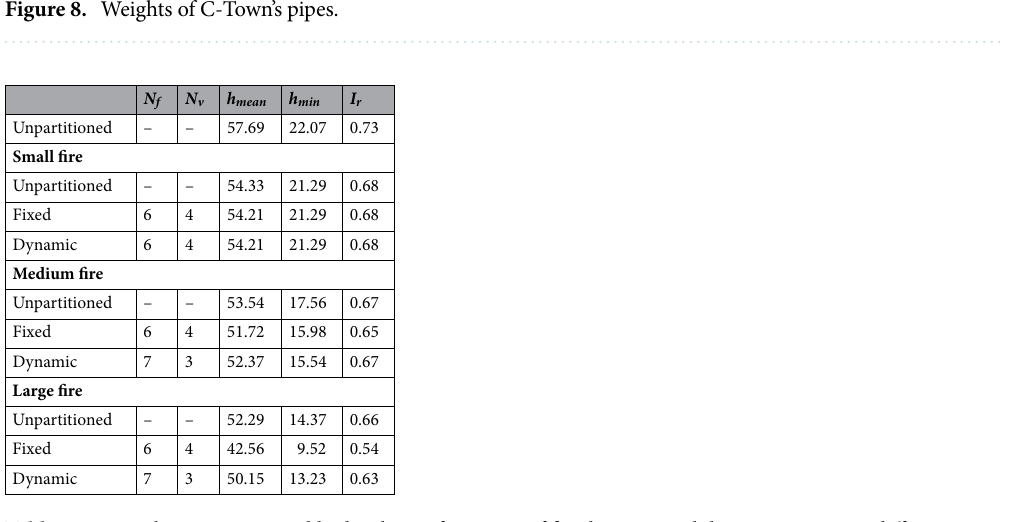
Table 2. Main characteristics and hydraulic performance of fixed DMAs and dynamic DMAs in different emergency